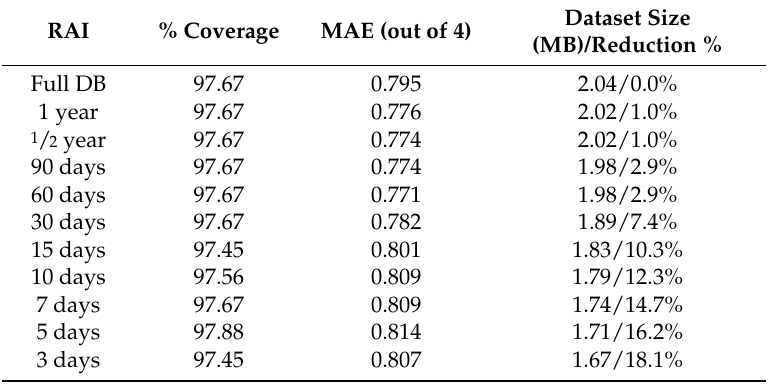
Table 7. MovieLens “100 K” dataset